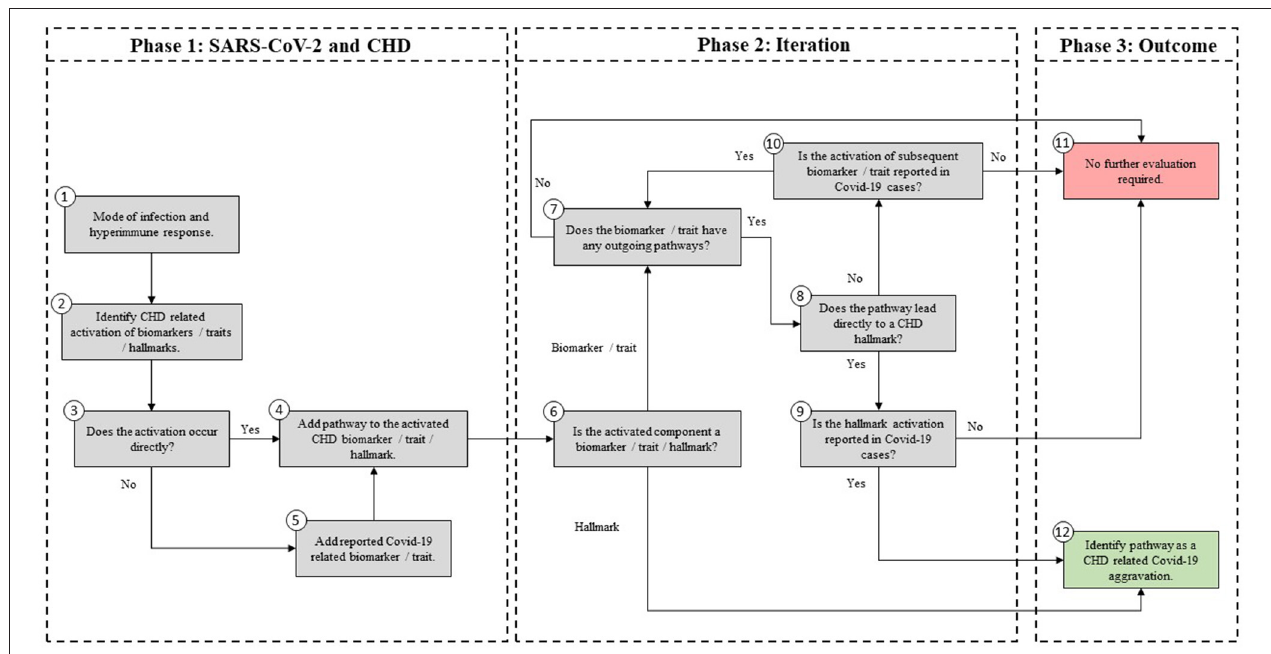
FIGURE 2 | Methodology used to develop an Integrated Covid-19/CHD model.